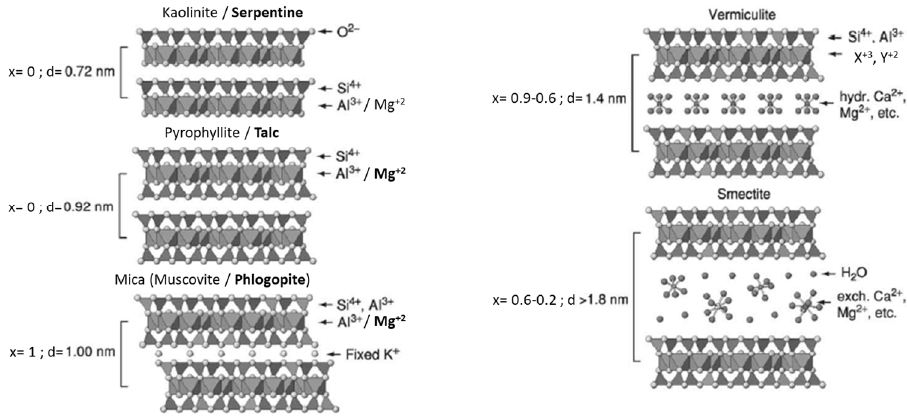
Figure 5. The representation of each group of phyllosilicates using the polyhedral model and respective charge (x) and layer to layer distance (d) Adapted from [21].